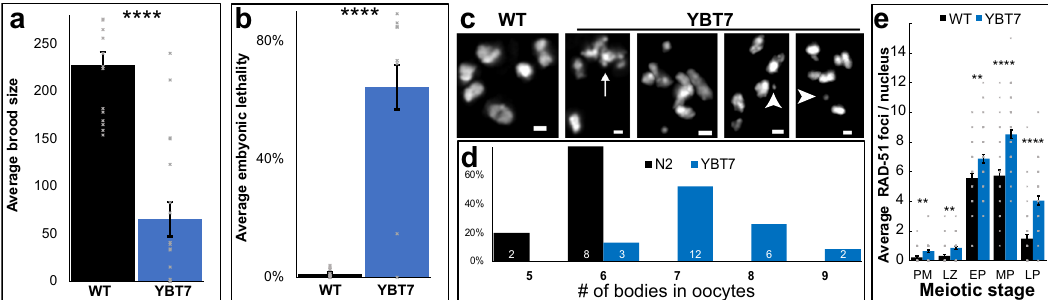
Fig. 4 Meiotic defects are present in YBT7. a Average± SEM brood size ( n = 16 and 18 worms for WT and YBT7) and b embryonic lethality ( n = 16 and 13 worms for WT and YBT7, p value = 0. 00006 by the two-tailed Mann – Whitney test) levels for wild-type and YBT7 progeny. c Mature wild-type and YBT7 oocytes stained with DAPI. Arrow indicates a chromosome aggregation. Arrowheads indicate chromosomal fragments. d Percentages of DAPI-stained bodies (excluding fragments) in wild-type and YBT7 oocytes. The number of scored oocytes is marked on the bars. e Average± SEM RAD-51 foci per nuclei at different oogonial stages. n = 40, 41, 47, 40, and 49 nuclei for WT PM pre-meiotic, LZ leptotene/zygotene, EP early pachytene, MP mid-pachytene, and LP (late pachytene, respectively and 60 nuclei for each stage in YBT7. Scale bar = 1 μ M. ** p < 0.01, *** p < 0.001, **** p < 0.0001, by the two-tailed Mann – Whitney